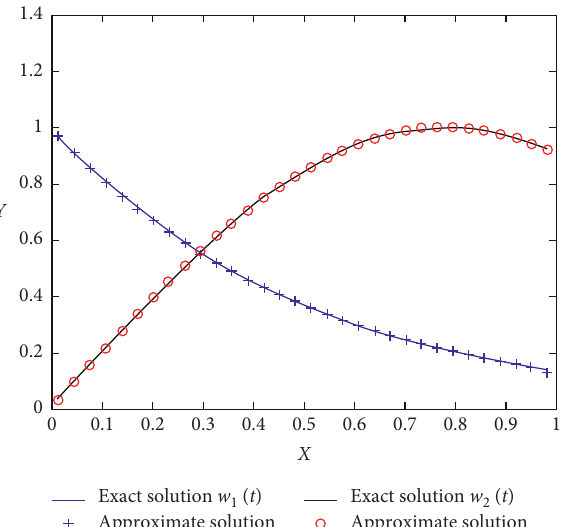
Figure 5: Comparison of exact and approximate solution for N � 32 for Problem